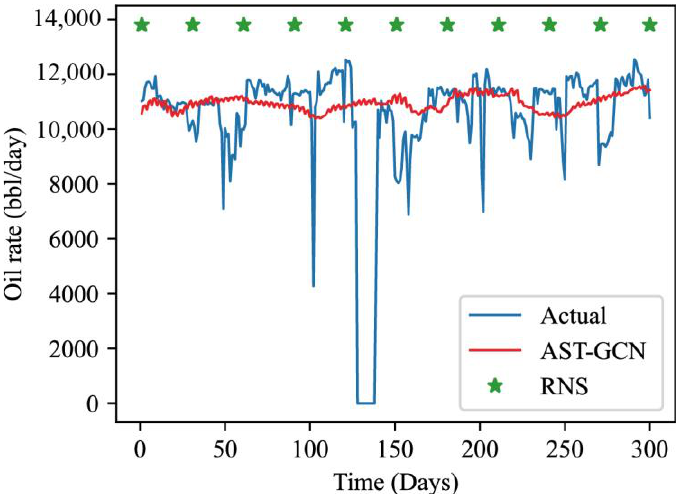
Figure 13. The predictive performance of daily oil production in whole well pattern.